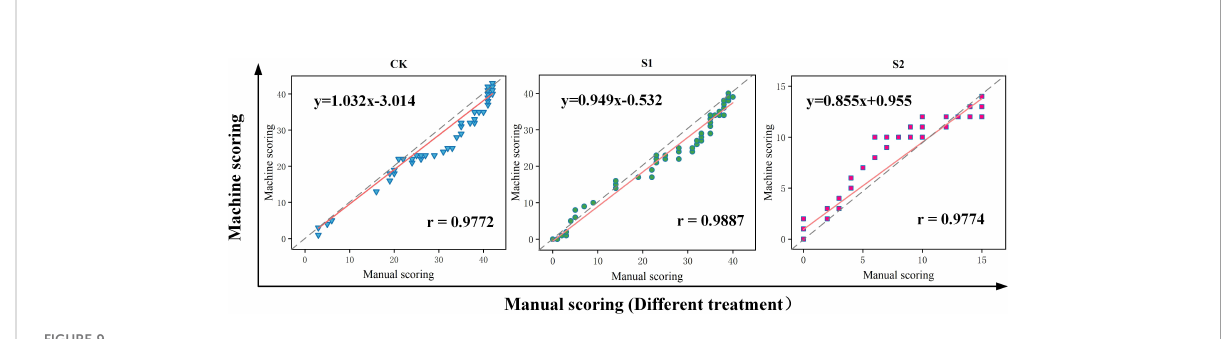
FIGURE 9 Linear correlation between manual scoring and machine